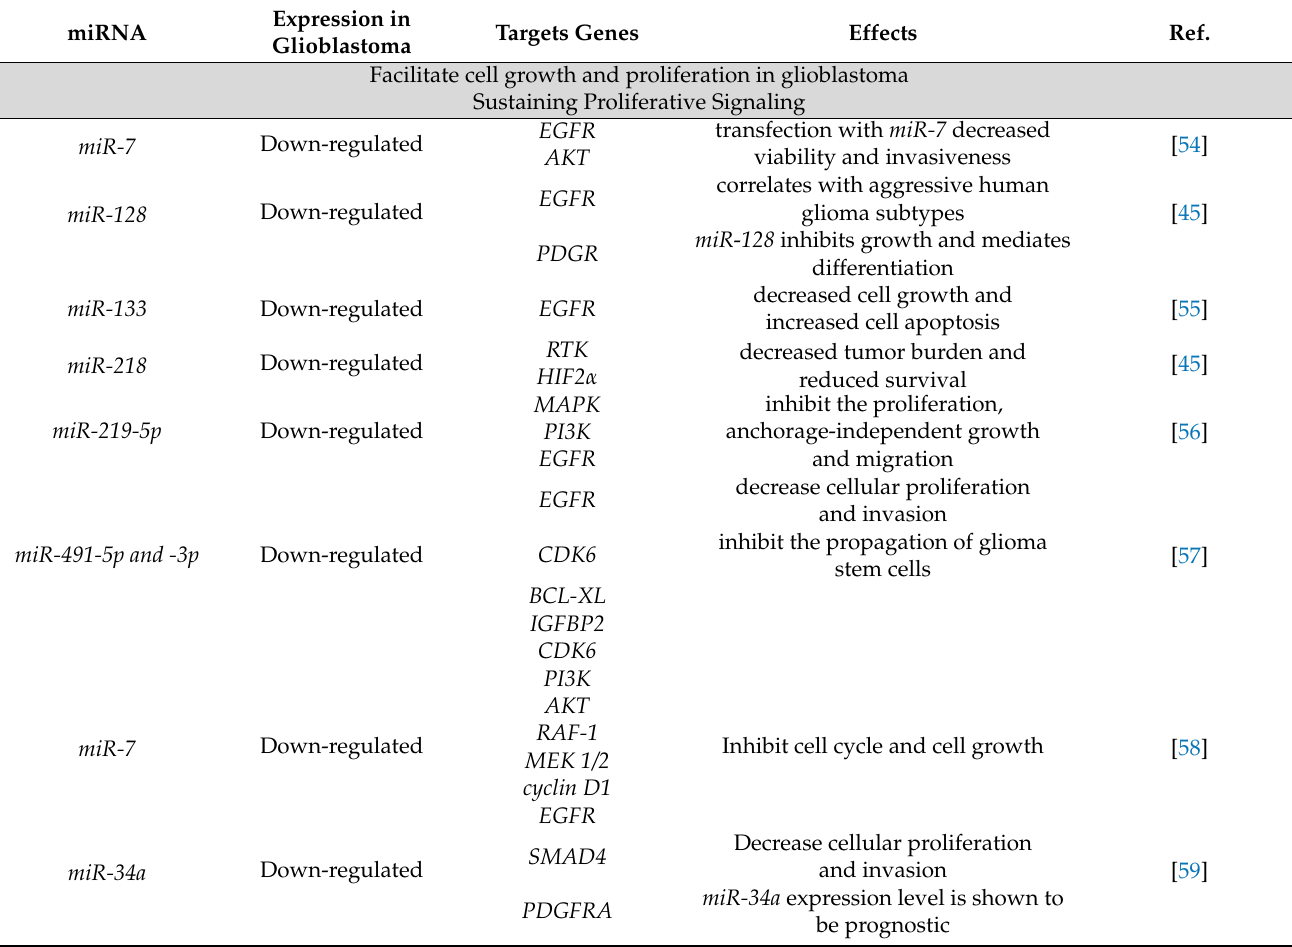
Table 1. Involvement of miRNAs in